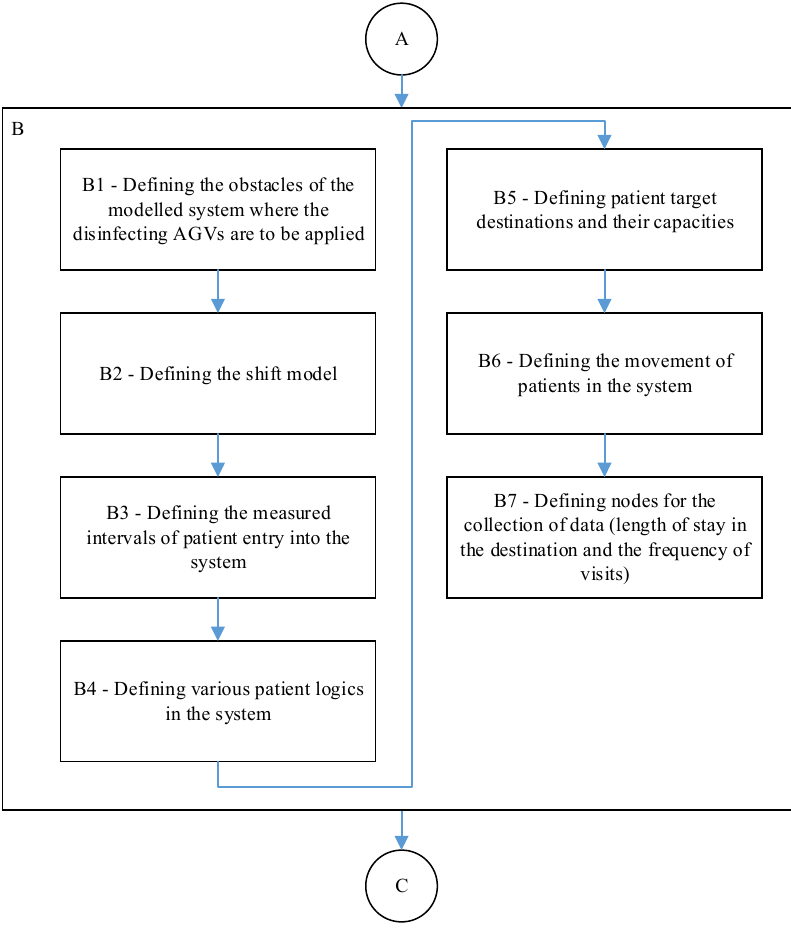
Figure 3. Block B phase of simulation model creation for the patient and medic parts.